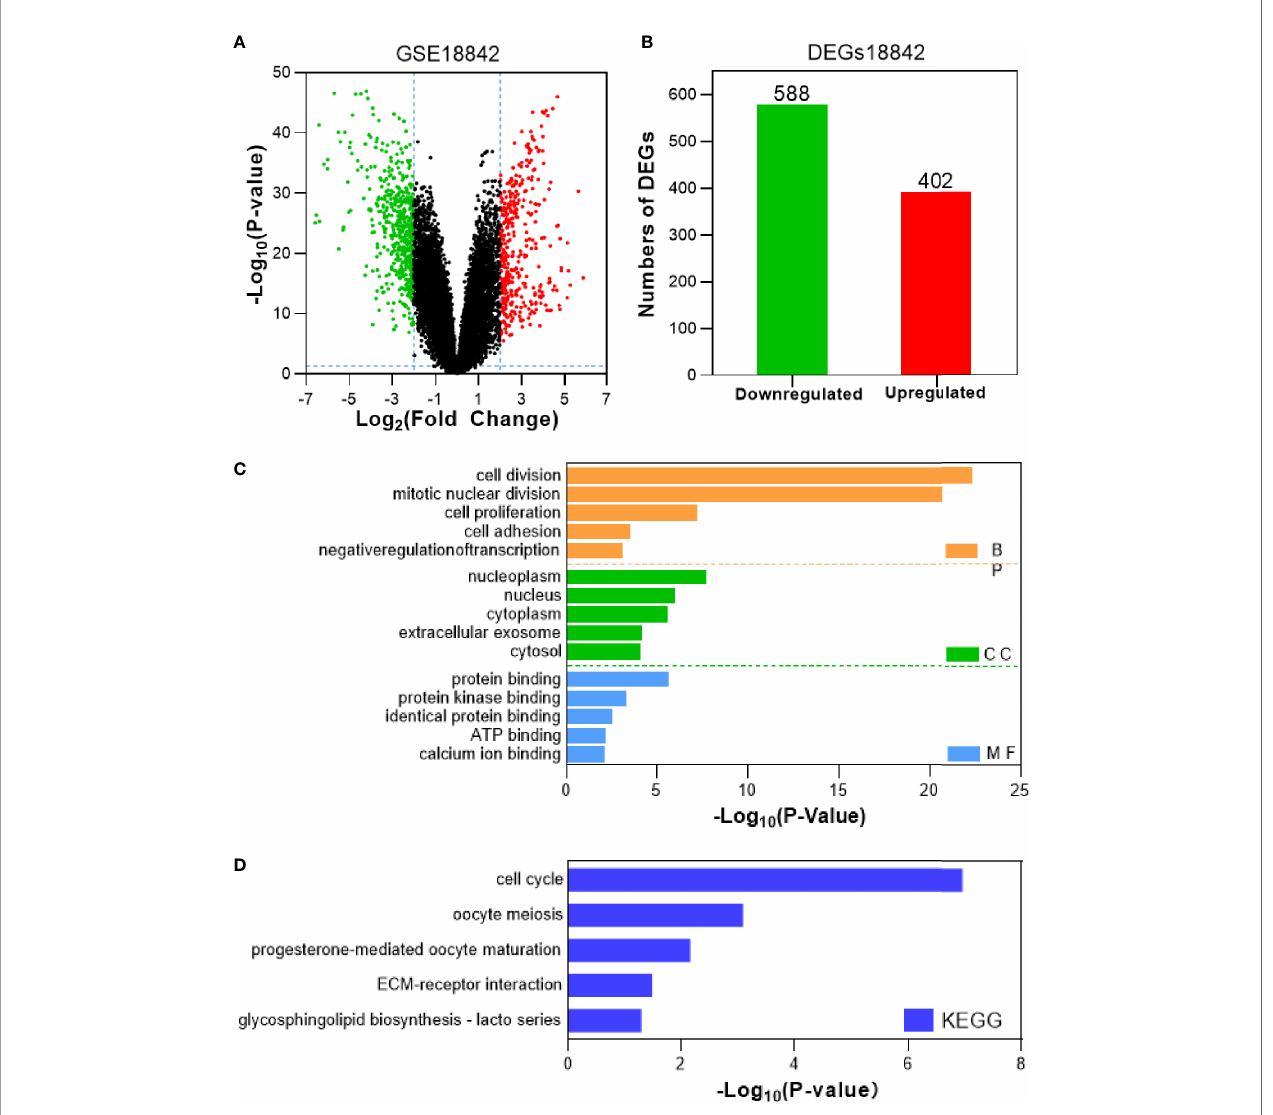
FIGURE 3 | Identi fi cation and characterization of DEGs from the GSE18842 dataset. (A) Volcano plot of DEGs between NSCLC tissues and adjacent normal tissues. Red dots are signi fi cantly upregulated DEGs in NSCLC tissues; green dots, DEGs downregulated in NSCLC tissues; black dots, genes with no signi fi cant difference (P<0.05 and |log2FC|>2 as the threshold). (B) Distribution of signi fi cant DEGs in NSCLC tissues. The top fi ve GO terms (C) and KEGG enriched pathways (D) of signi fi cantly upregulated DEGs in NSCLC tissues are indicated. BP, biological process; CC, cell component; MF, molecular